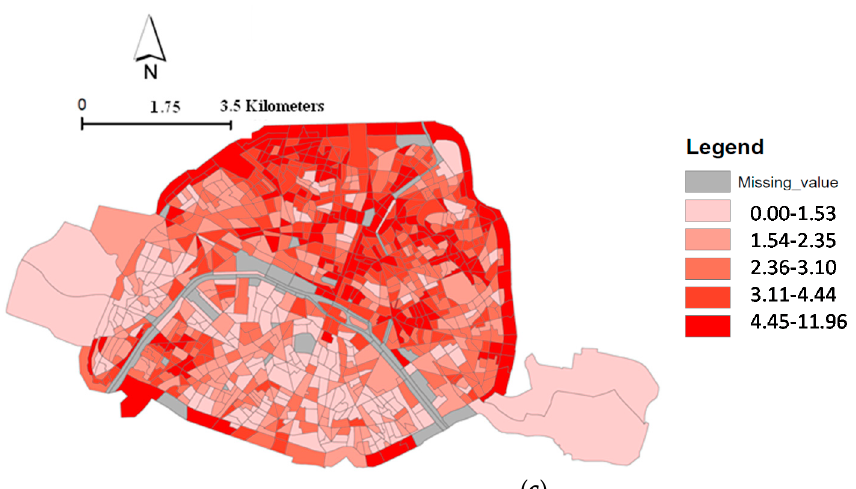
Figure 3. Spatial distribution of the rate of adults deaths attributable to NO 2 among total death, at the census block level, Paris city; ( a ) without spatial variability of NO 2 exposure in Paris; ( b ) with spatial variability of NO 2 between census blocks; ( c ) with spatial variability of NO 2 and socio-economic level between census blocks (according Dutch study [14]).